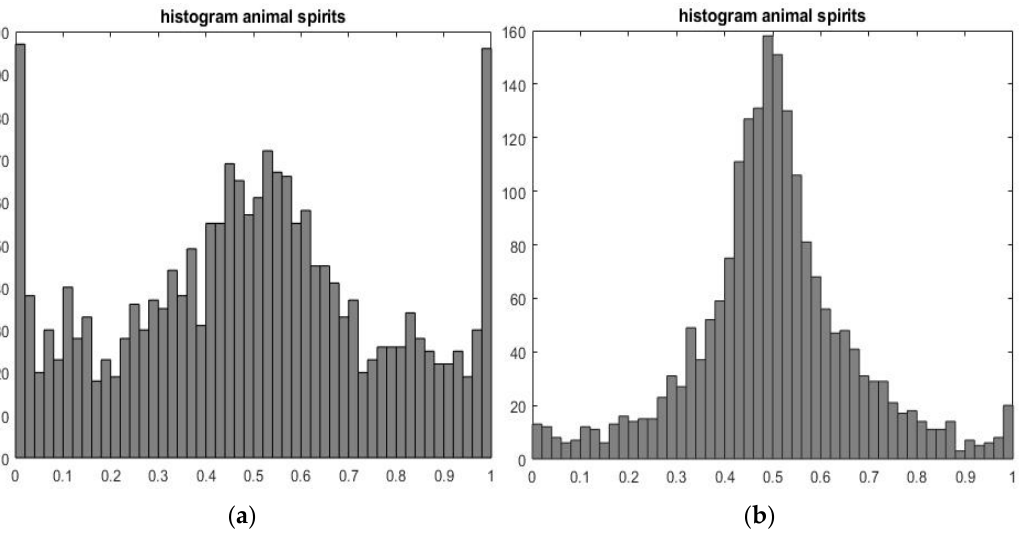
Figure 1. The histogram of the frequency distribution of the degree of optimism and pessimism: ( a ) for the model under study with an imperfect labor market and rigid prices; ( b ) for the basic model with fixed prices and flexible wages.